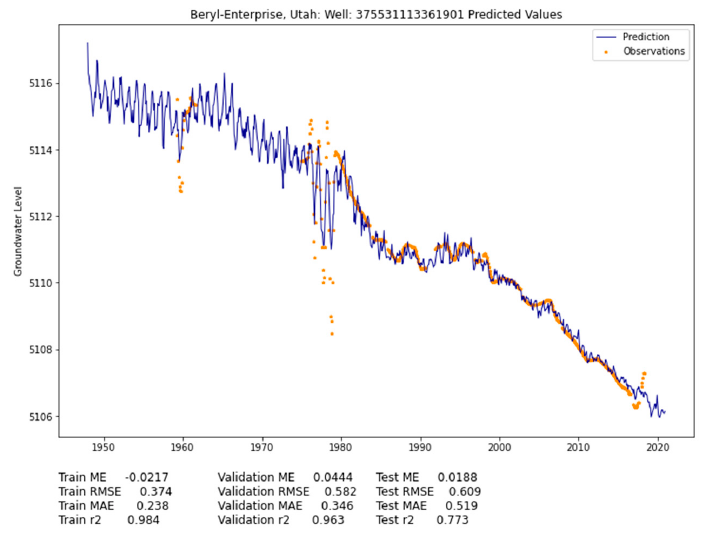
Figure 12. Well 375531113361901 in Beryl-Enterprise, showing groundwater observations and model predictions.